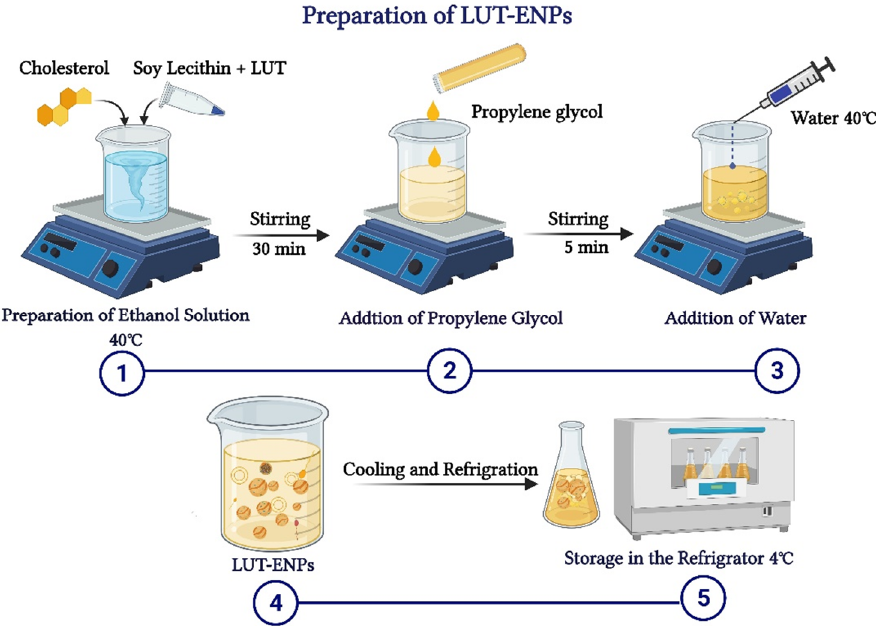
Figure 1. Schematic diagram showing the detailed cold method steps for preparation of luteolin- loaded ethosomal nanoparticles (LUT-ENPs). Table 1. Composition of different LUT-ENPs formulations.